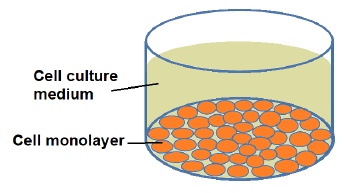
Figure 5. Schematic representation of the 2D cell culture where cells are seeded as individual cell into a cell culture